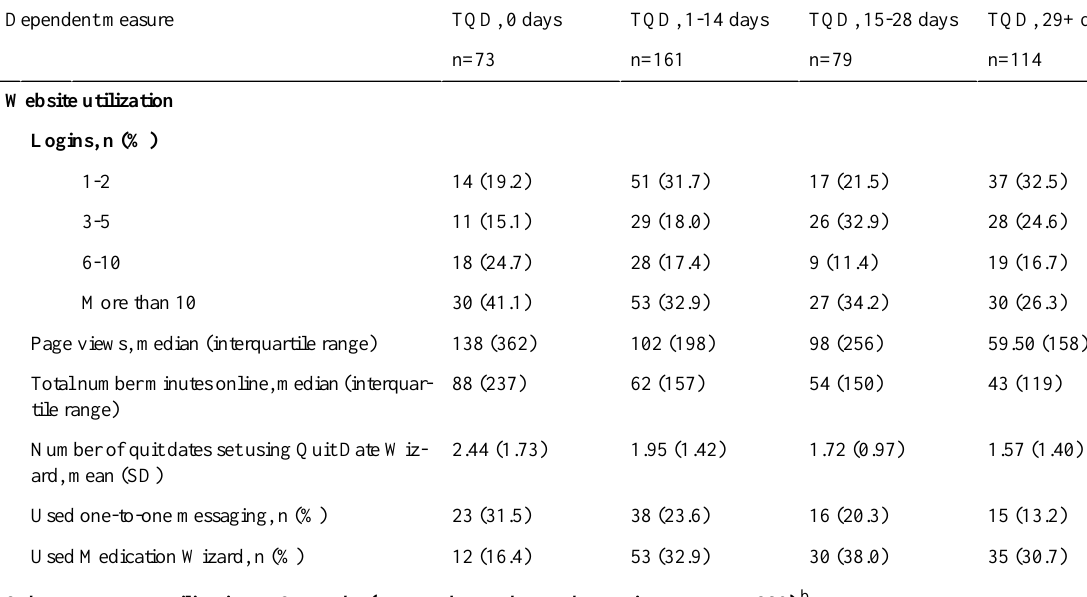
P value a TQD, 29+ daysTQD, 15-28 daysTQD, 1-14 daysTQD, 0 daysDependent